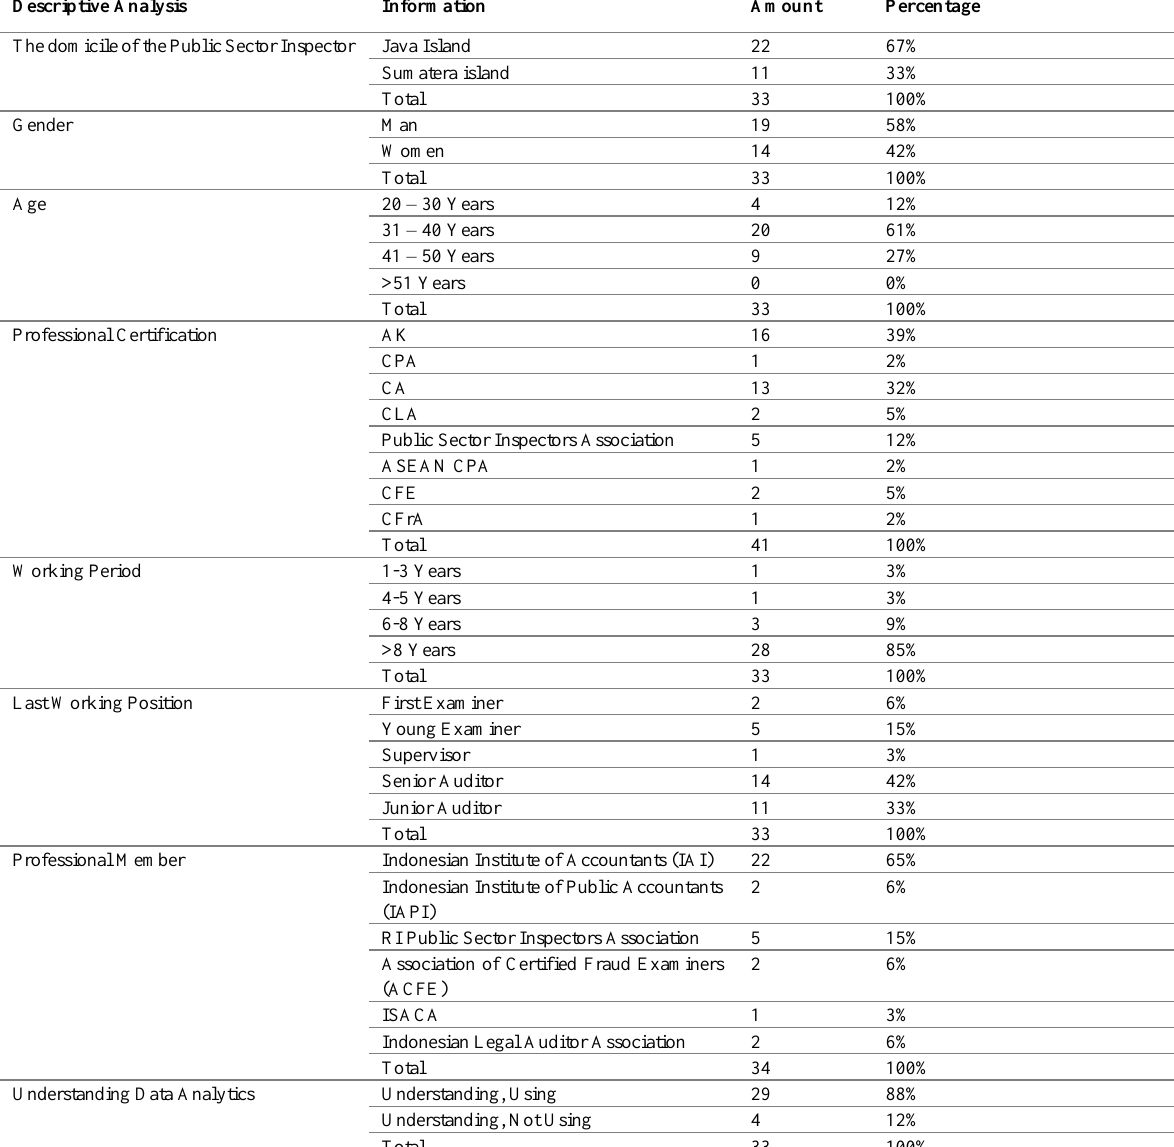
Table 1: Description of